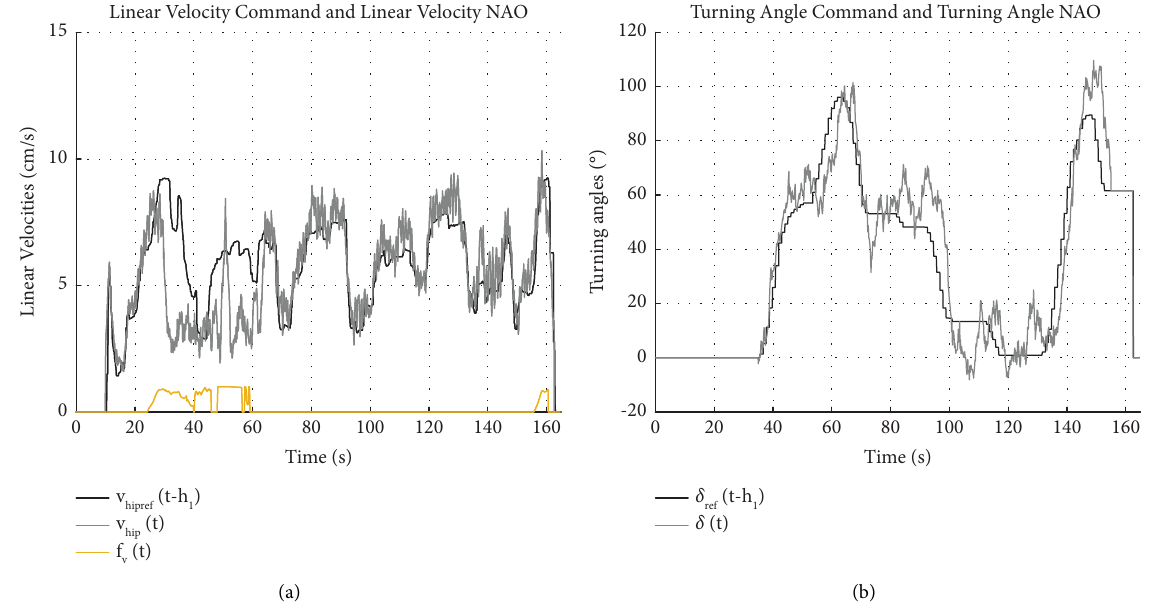
Figure 12: Forward velocity and Turn angle references generated by the human operator and the signals provided by the humanoid robot: (a) linear velocity command and linear velocity NAO and (b) turning angle command and turning angle